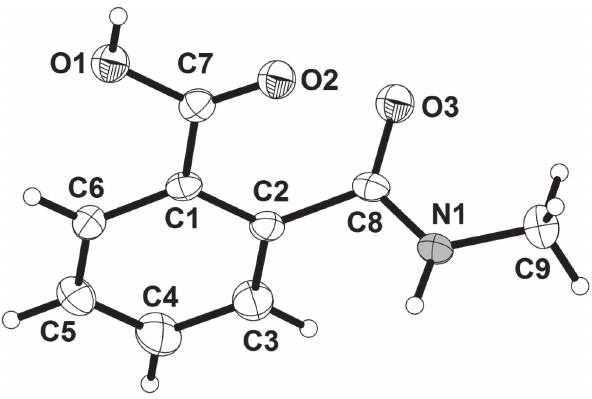
Table 2: Fractional atomic coordinates and isotropic or equivalent isotropic displacement parameters (Å 2